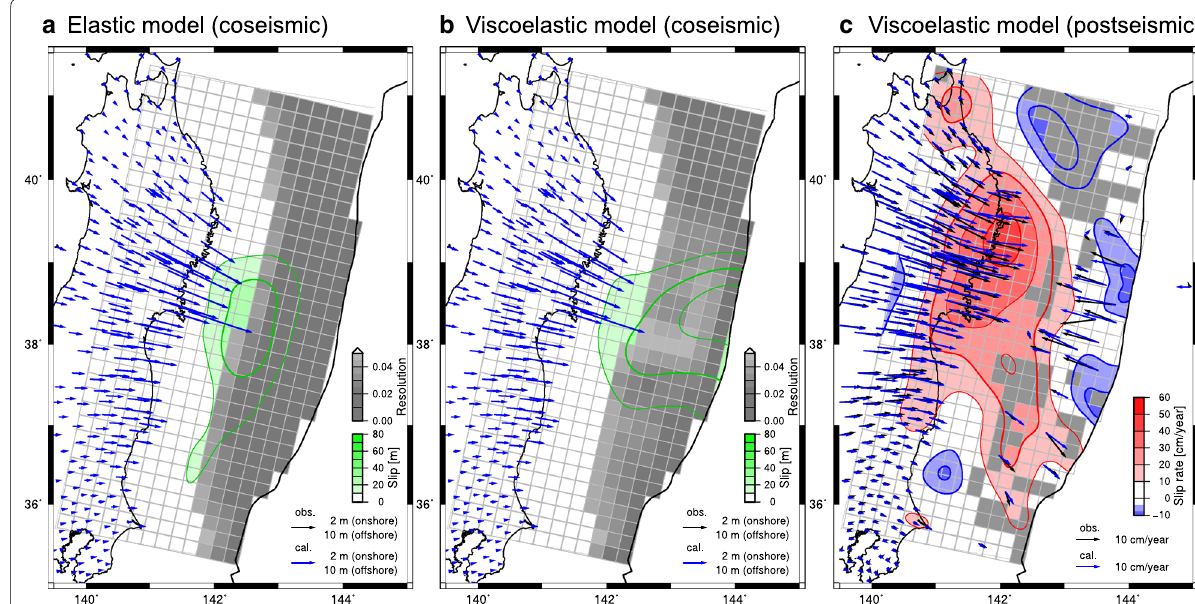
Fig. 14 Co- and post-seismic slip models without using coseismic seafloor observations. a – c The co- and post-seismic slip models estimated by the elastic and viscoelastic inversions without using seafloor geodetic observational data during the coseismic period. These panels are drawn in the same manner as with Fig 11, except the gray patches expressing low spatial resolution in a and b . Gray-scaled patches in panels a and b indicate degree of low spatial resolution (resolution <